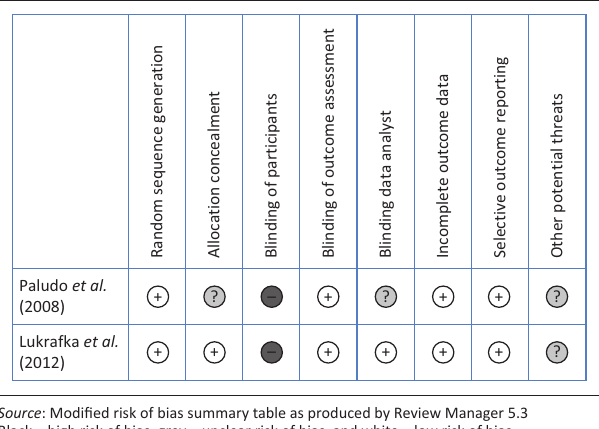
FIGURE 2: Risk of bias summary: review of authors’ judgements about each risk of bias item for each included